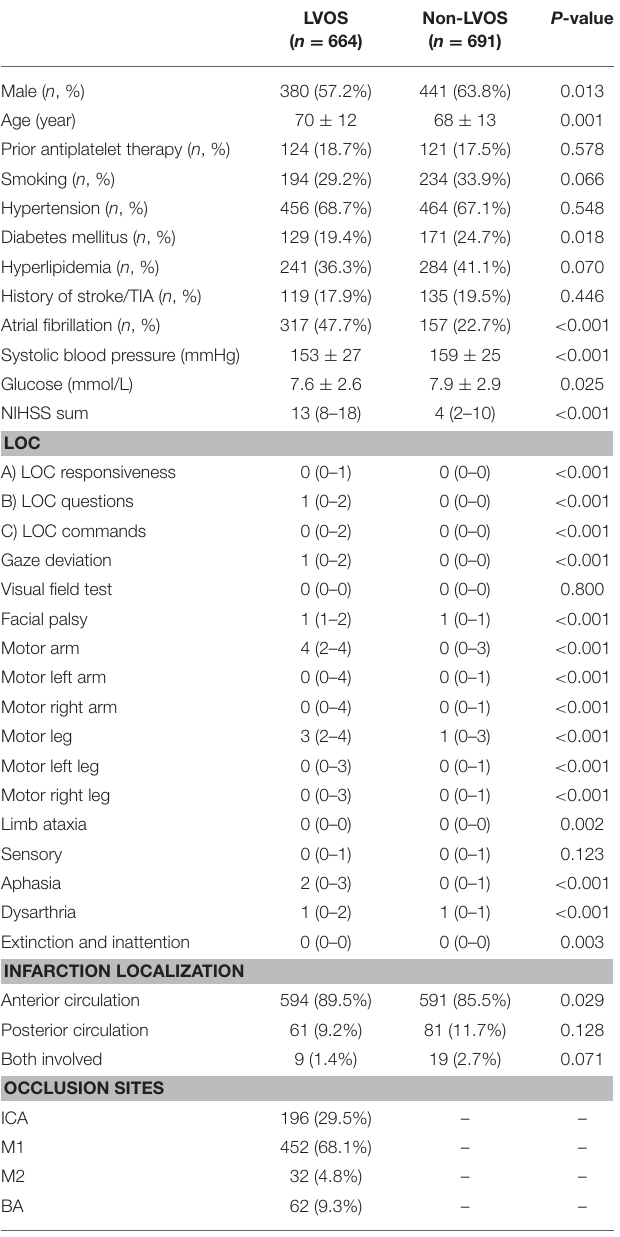
TABLE 2 | Comparison of baseline variables between LVOS and non-LVOS patients.